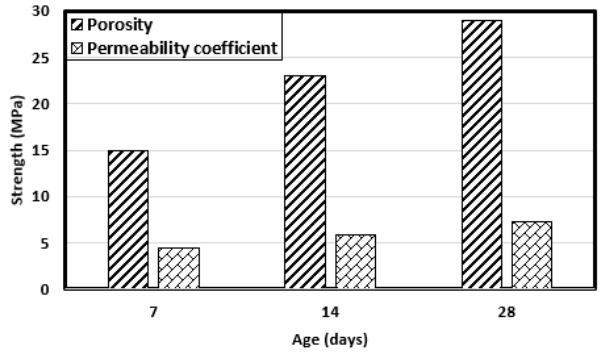
Figure 8. Strength test results.